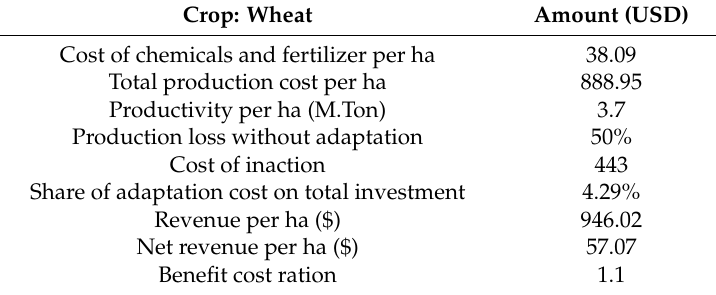
Table 8. Economic analysis of applying extra chemicals and fertilizers to face cold